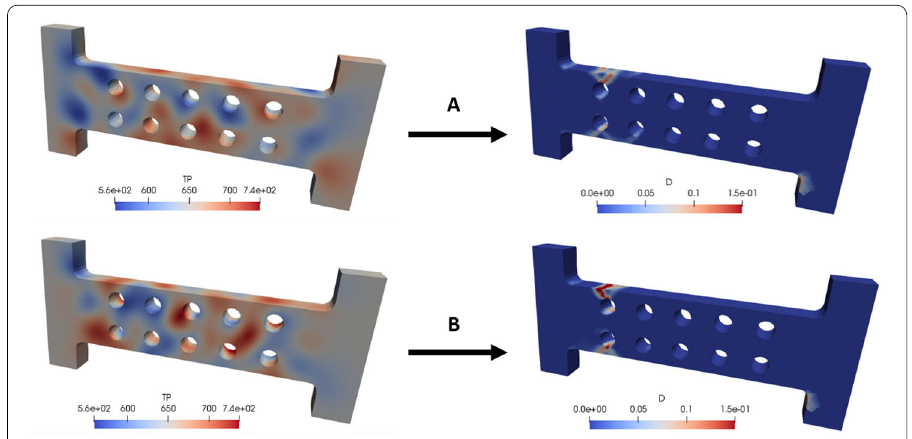
Fig. 6 Influence of the temperature field. Two damage fields (on the right) obtained from two different temperature fields (on the left)